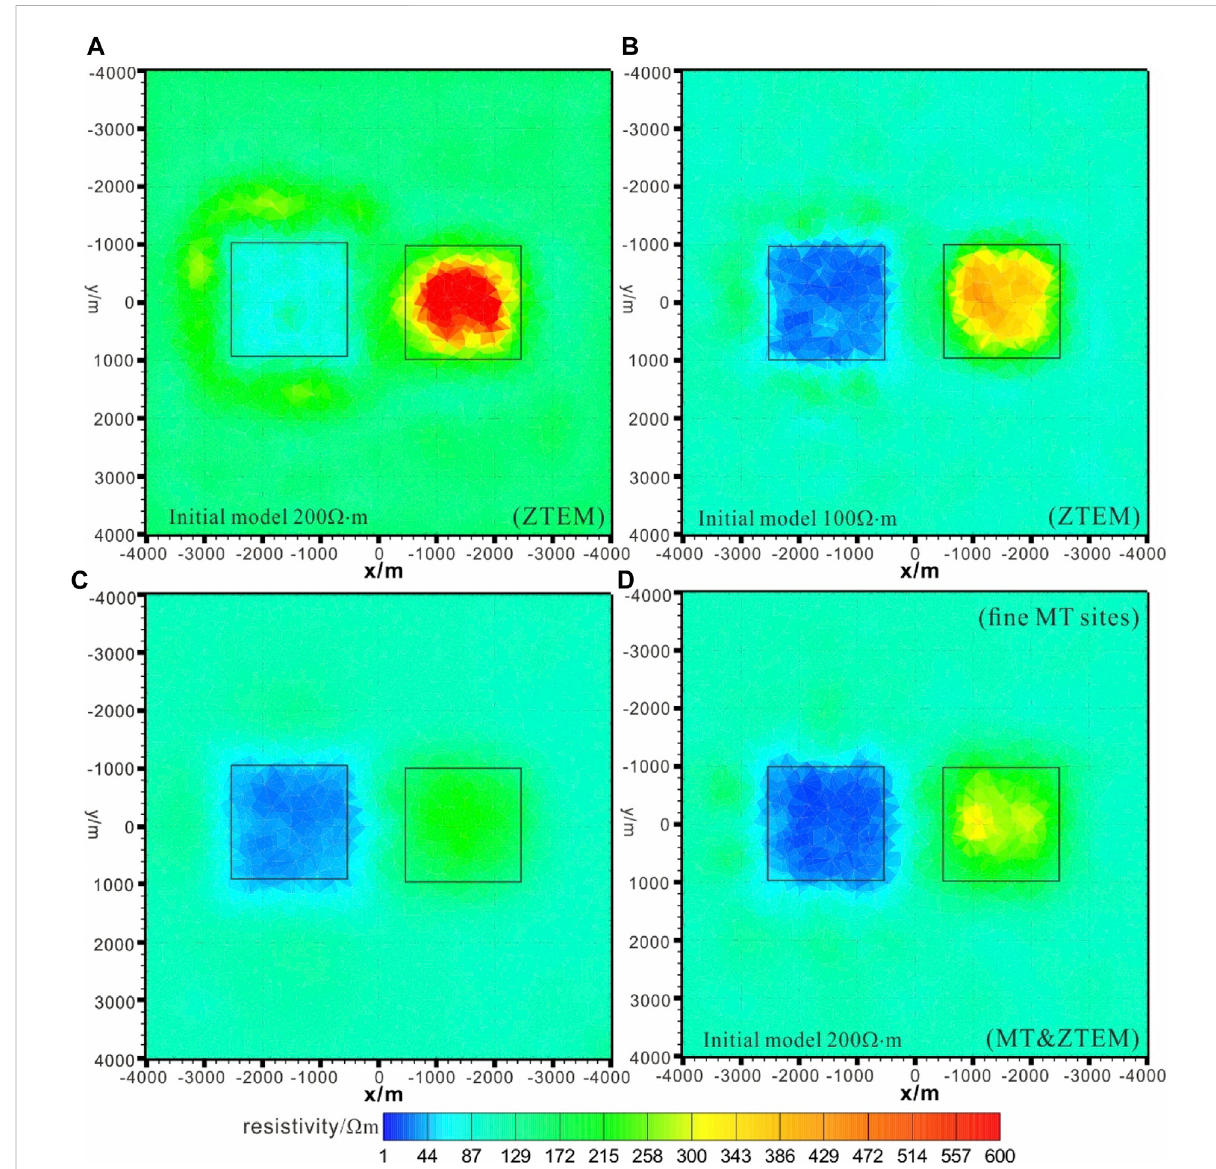
FIGURE 11 Inversion results for the synthetic model at the xy section for z =500 m. (A,B) and (C) are the MT inversion, ZTEM inversion, and joint MT and ZTEM inversion with initial model and a 200 Ω · m half-space, respectively. (D) is the ZTEM inversion with a 100 Ω · m